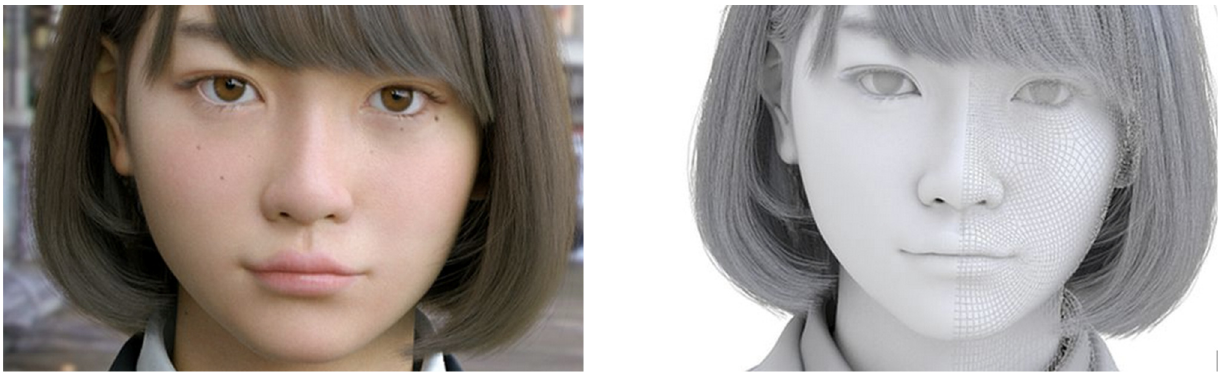
Figure 3. CGI Project, “Saya”. Source : Tan (2016).